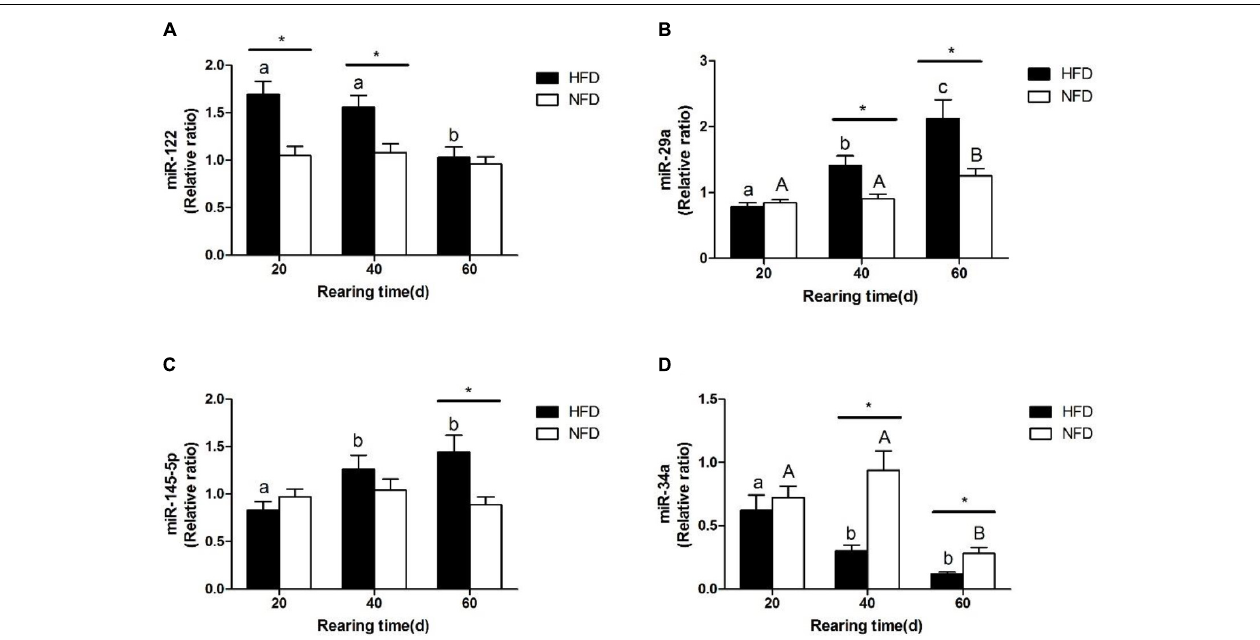
FIGURE 6 | Expression levels of (A) miR-122; (B) miR-29a; (C) miR-145-5p and (D) miR-34a in liver of GIFT fed experimental diets on day 20, 40, and 60 ( n = 9 replicates per group). Significant differences ( P < 0.05) between high-fat diet (HFD) and normal-fat diet (NFD) groups at same sampling time are marked by asterisks ( ∗ ). Different superscript lowercase letters show significant differences ( P < 0.05) in HFD group among different sampling times. Different superscript uppercase letters indicate significant differences ( P < 0.05) in NFD group among different sampling times.